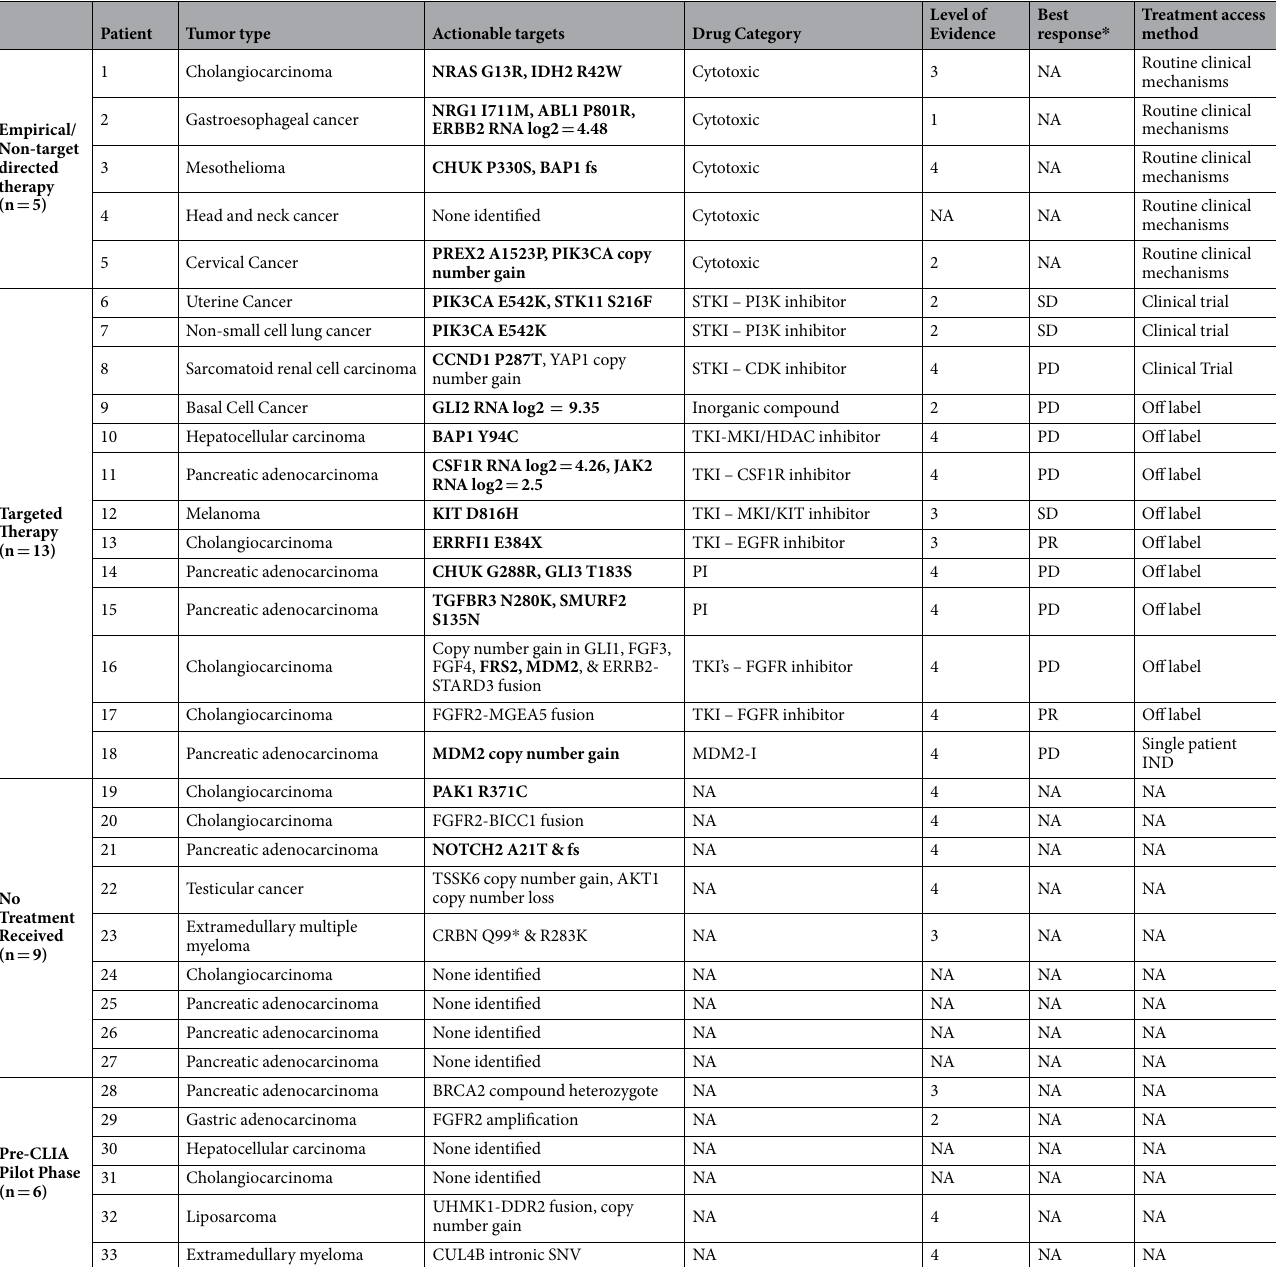
Table 2. Summary of identified targets, treatments and responses. * RECIST response or equivalent data was not available for those patients who did not pursue genomic target directed therapy, NA = not applicable, BOLD indicates targets that validated independently in a CLIA certified laboratory, fs = frameshift, SNV = single nucleotide variant, STKI = serine threonine kinase inhibitor, PI3K = phosphatidylinositol 3-kinase, CDK = cyclin dependent kinase, TKI = tyrosine kinase inhibitor, MKI = multi-kinase inhibitor, CSF1R = colony stimulating factor 1 receptor, KIT = KIT proto-oncogene receptor tyrosine kinase, EGFR = epidermal growth factor receptor, FGFR = fibroblast growth factor receptor, HDAC = histone deacetylase, PI = proteasome inhibitor, MDM2-I = MDM2 inhibitor. Level of evidence: 1 = Validated clinical, 2 = Preclinical/limited clinical, 3 = Pre-clinical, 4 = Hypothetical/knowledge